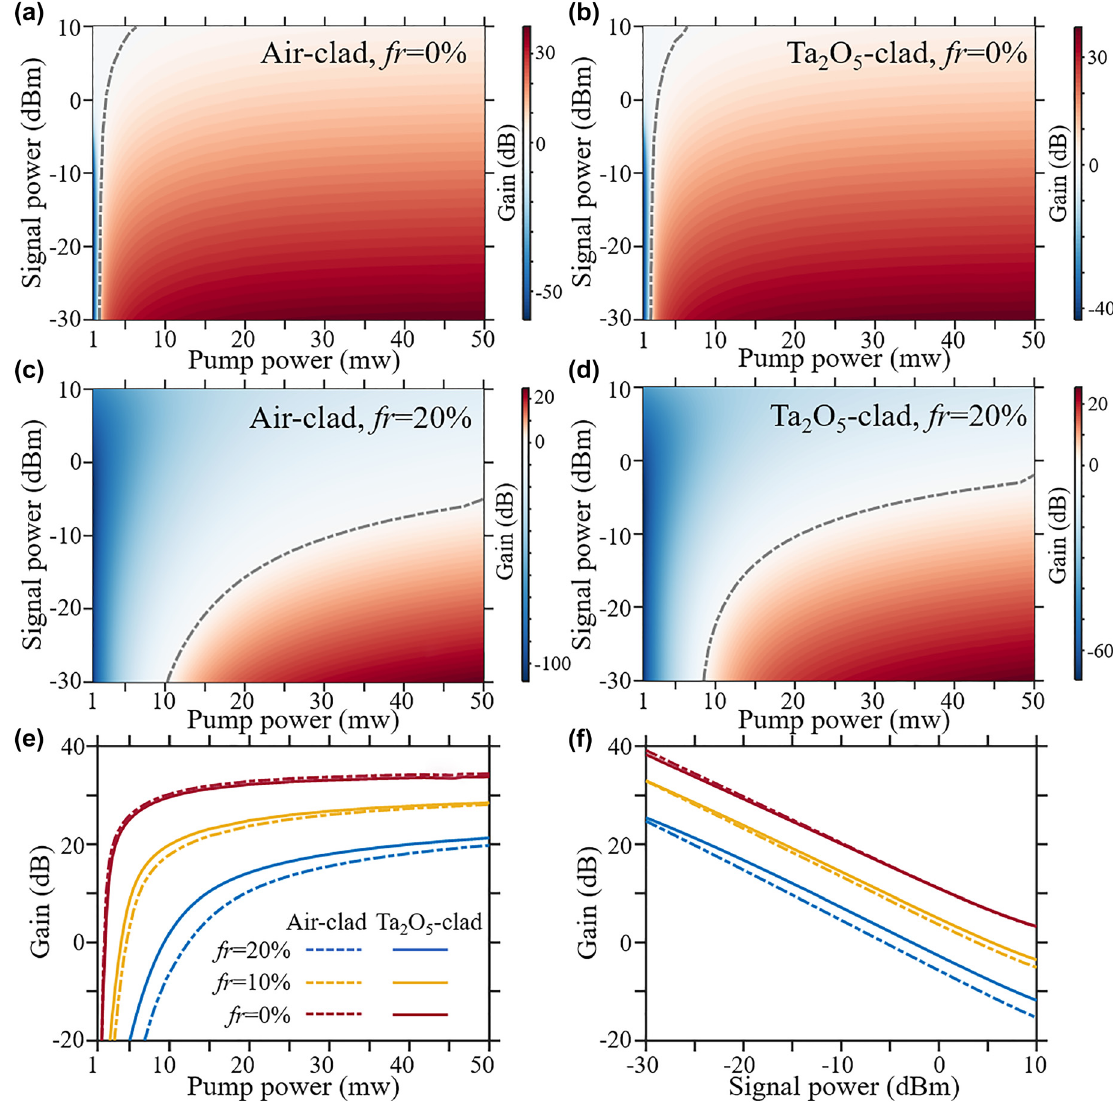
Figure 5: The simulated gain response for both waveguide amplifiers. The gain map calculated at each pair of signal and pump powers is depicted in pseudo-colors for air-clad amplifier (a) and (c), Ta 2 O 5 -clad ampli fi er (b) and (d). The fractions of quenched erbium ions are labelled in each panel. The gain curve versus pump power and the gain curve versus signal power are plotted in (e) and (f). The same fi gure legend is applied for (e) and